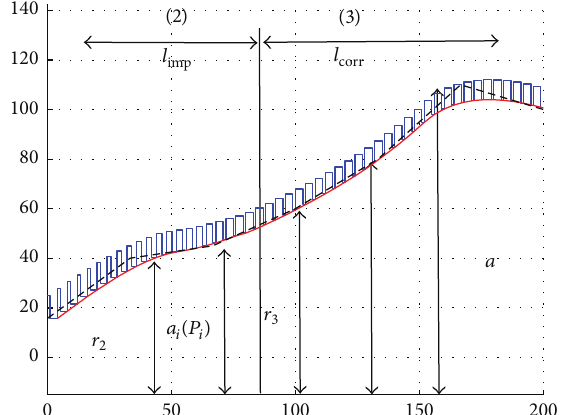
Figure 3: Profile horn defined by NURBS curve with five control points.